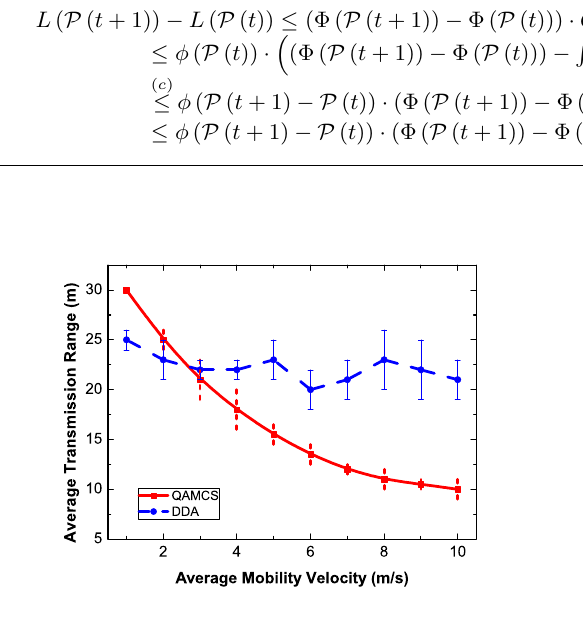
Figure 2: ¯ R comparison when U = 40